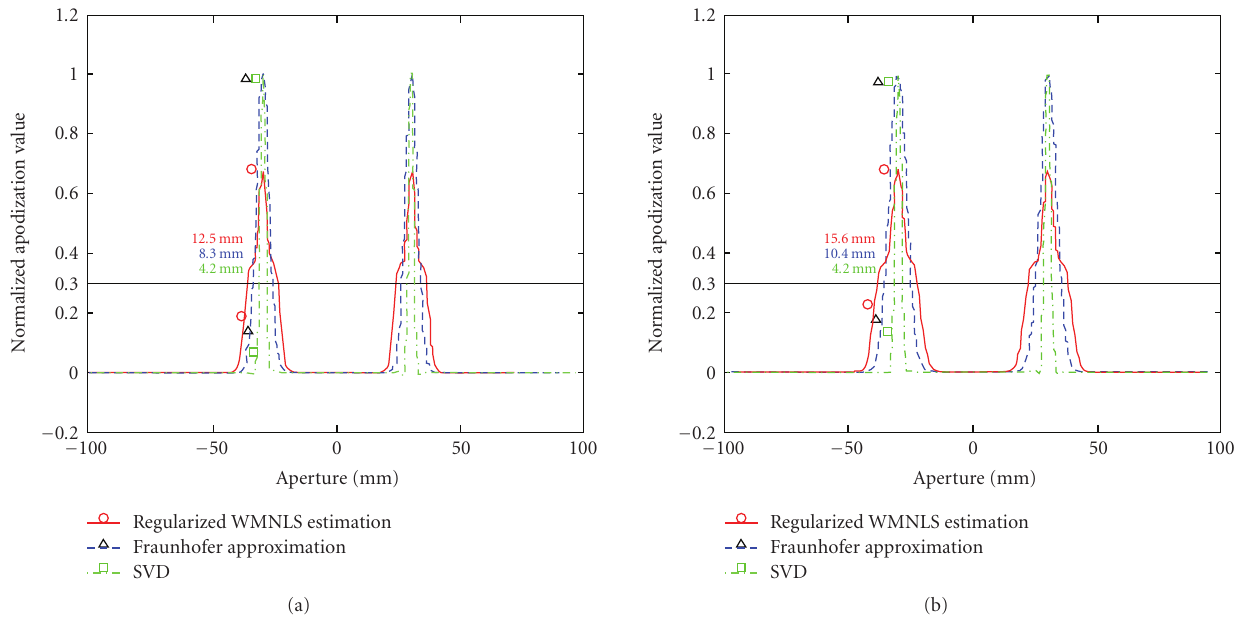
Figure 1: Apodization functions obtained using a regularized WMNLS estimation (solid line with circles), a Fraunhofer approximation (dashed line with triangles), and a SVD (dash-dot line with squares) for designed lateral Gaussian-type PSFs with (a) σ y = 0.8 and (b) 0.6mm. The widths of two peaks at the normalized apodization value 0.3 are also